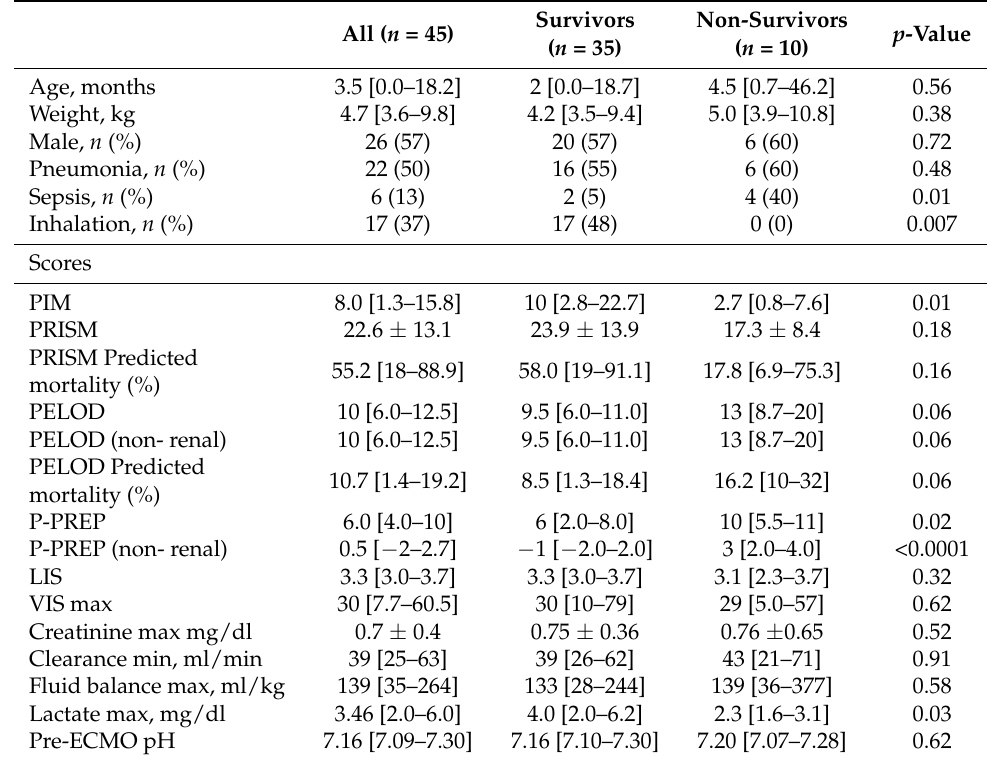
Table 6. Comparison of survivors vs. non